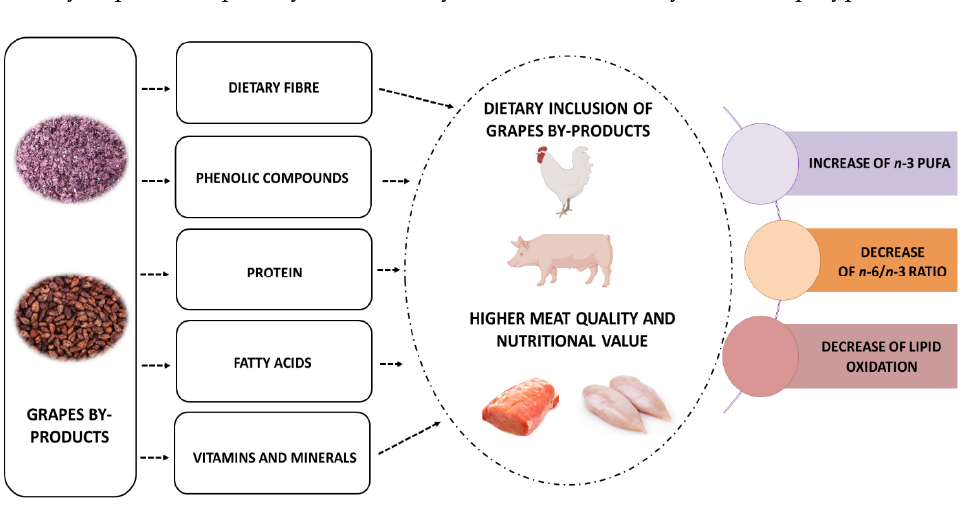
Figure 1. Major impacts of feeding poultry and swine with grape by-products on meat